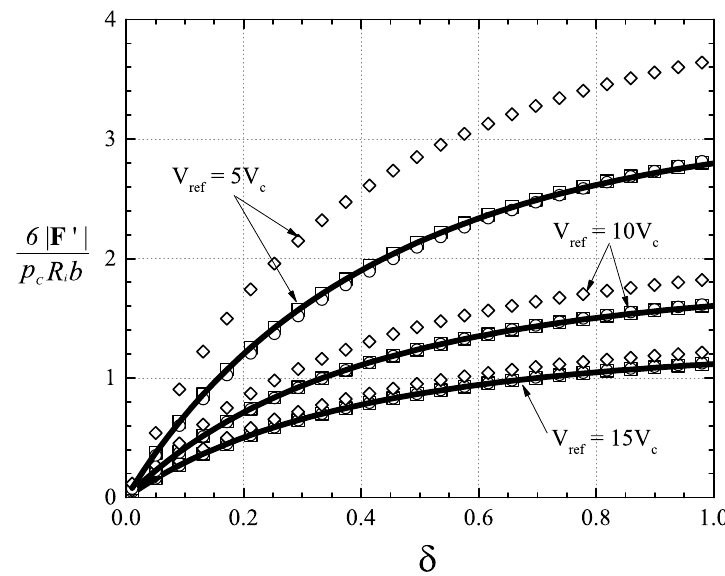
Figure 10. Scaled load vs. δ at V ref = 5 V c , 10 V c and 15 V c for T ref = 1.05 T c . The speed number Λ = 50. The solid lines represent the scaled load obtained from the REGM model; the symbols (cid:3) , (cid:13) , and